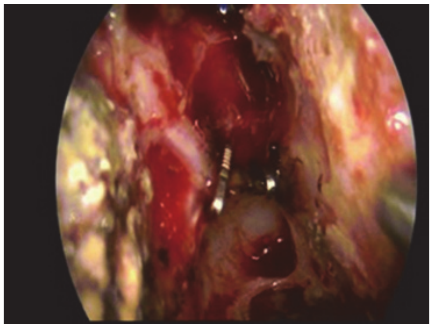
Figure 8: Endoscopic image: posterior ethmoidal artery: hemosta- sis with diamond